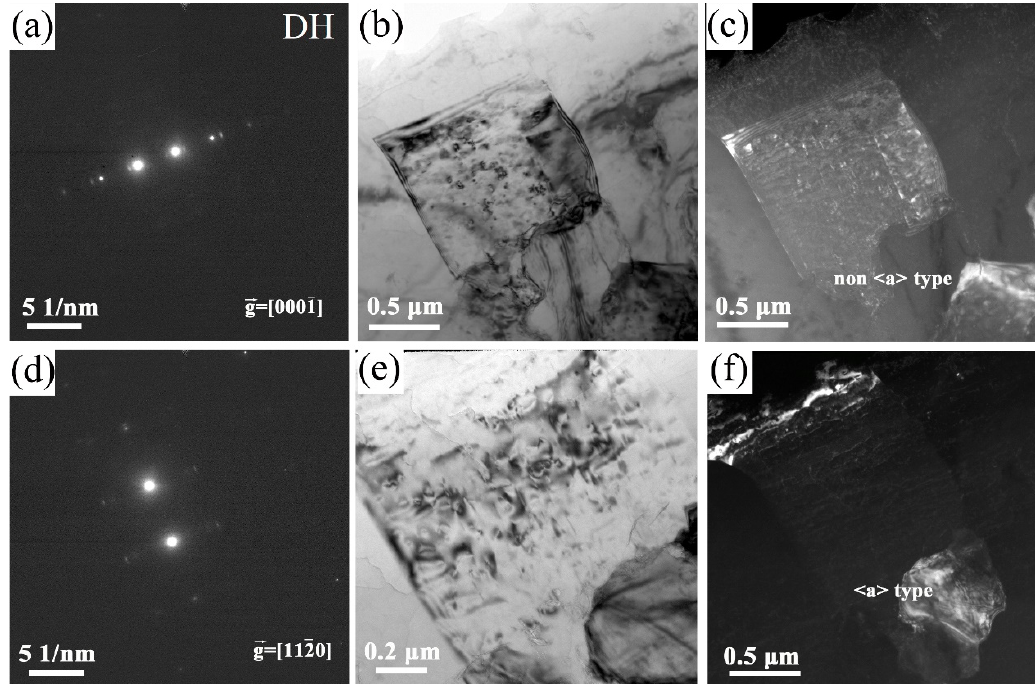
Figure 5. TEM images of initial dislocations in DH sample (3.1 µ m grain size): ( a – c ), non- < a > type (g = [0001]), B close to [1010 ]); ( d – f ), < a > type (g = [1120 ], B close to [1010 ]); ( a , d ) selected area electron di ff raction (SAED) patterns; ( b , e ) bright field images; ( c , f ) dark field images.